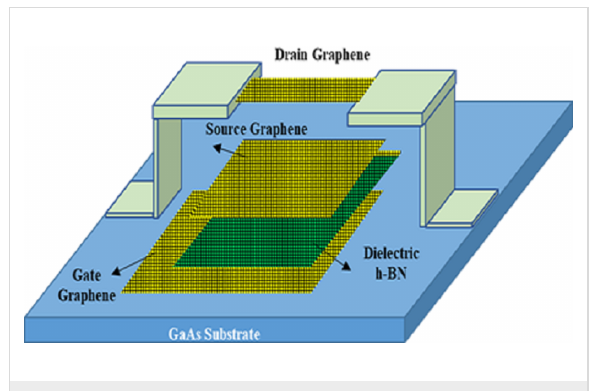
Figure 4: All flexible structure of a GR switch. Figure 4 was redrawn from [5].